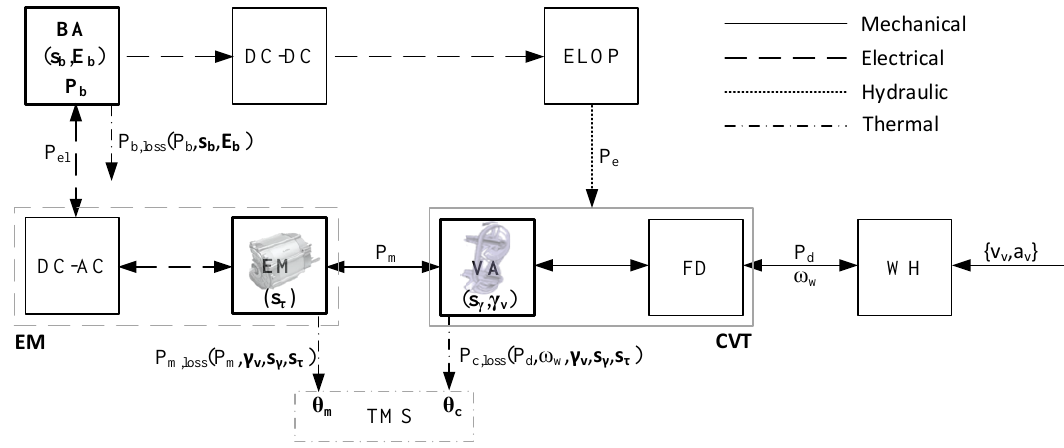
Figure 2. A CVT-based electric vehicle, where BA represents the battery, DC-AC the DC (direct current) to AC (alternating current) inverter, DC-DC the DC to DC converter, ELOP the electric oil pump, FD the final drive, VA the variator, and WH the wheel. Design, control, and state variables are highlighted in